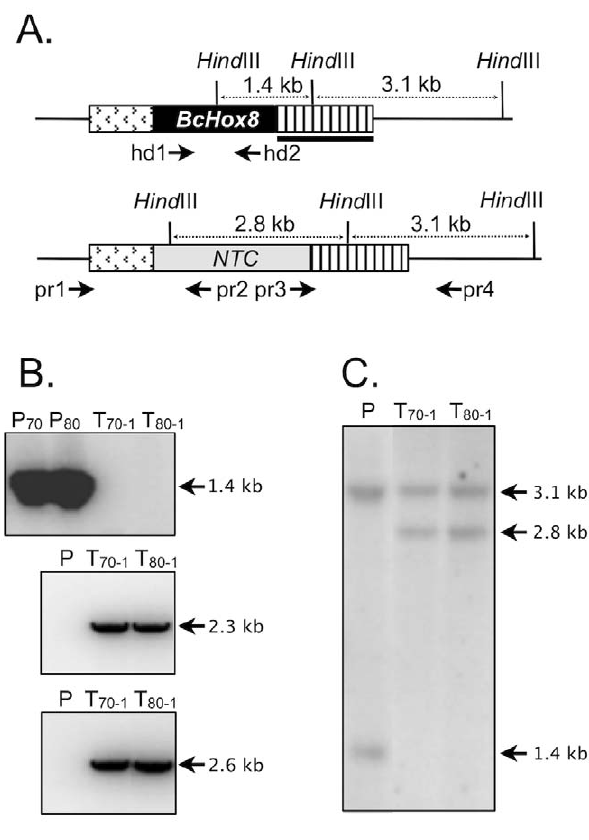
Figure 1. Deletion of the BcHOX8 gene. (A) Schematic represen- tation of the BcHOX8 gene replacement by the nourseothricin (NTC) resistance gene flanked by 1.5 kb of downstream and 0.95 kb of upstream sequences from the BcHOX8 locus. Distances between HindIII restriction sites are shown with dotted double arrows. The probe used for Southern analysis and the primers used for PCR analysis are shown as a black bar and arrows, respectively. (B) PCR analysis of the parental (T4/ D ku80 (P80) and B05-10/ D ku70 (P70)) and transformed strains (T4- T 80-1 (T 80-1 ) and B05-T 70-1 (T 70-1 )) using three primers (shown in A) combinations: hd1 and hd2 (top), pr1 and pr2 (middle) or pr3 and pr4 (bottom). (C) Southern blotting analysis of the parental T4/ D ku80 strain (P) and one transformant of each genetic background (T4-T 80-1 and B05- T 70-1 ) using HindIII to digest genomic DNA and the DNA probe indicated in (A) to reveal the fragments.